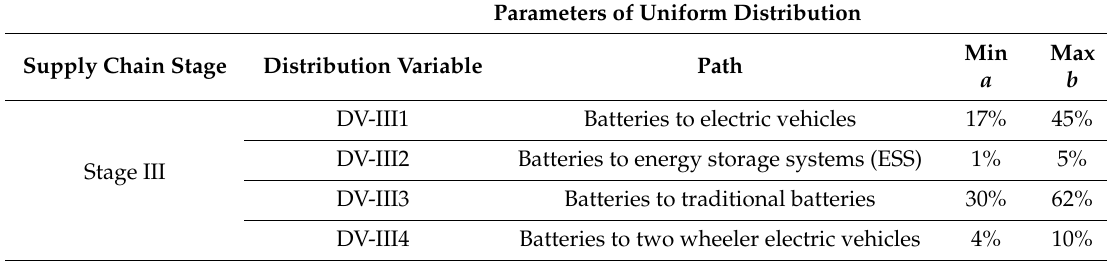
Table 4. Maximum and minimum values for the uniform distribution in the third stage of the supply chain. The paths represent the distribution of